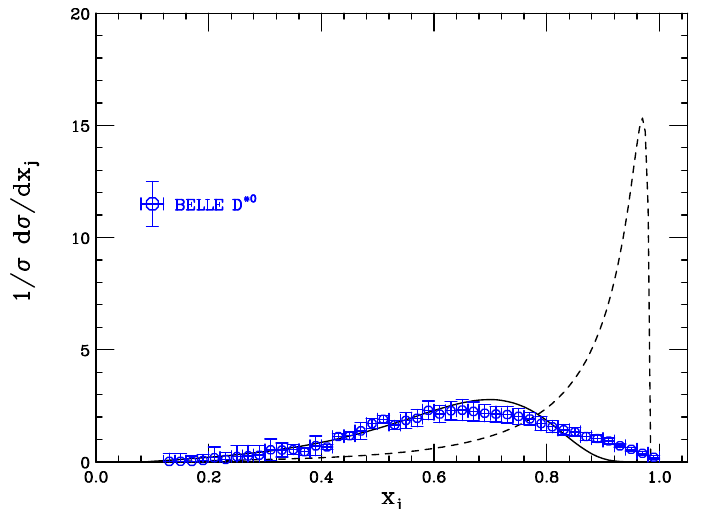
Figure 5. BELLE data on D ∗ 0 production at the Υ ( 4 S ) pole, compared with the perturbative calcu- lation described in the text and in [23], using an effective (solid) and standard coupling constant (dashes). Perturbative parameters are set as in the results shown in Figure 4.